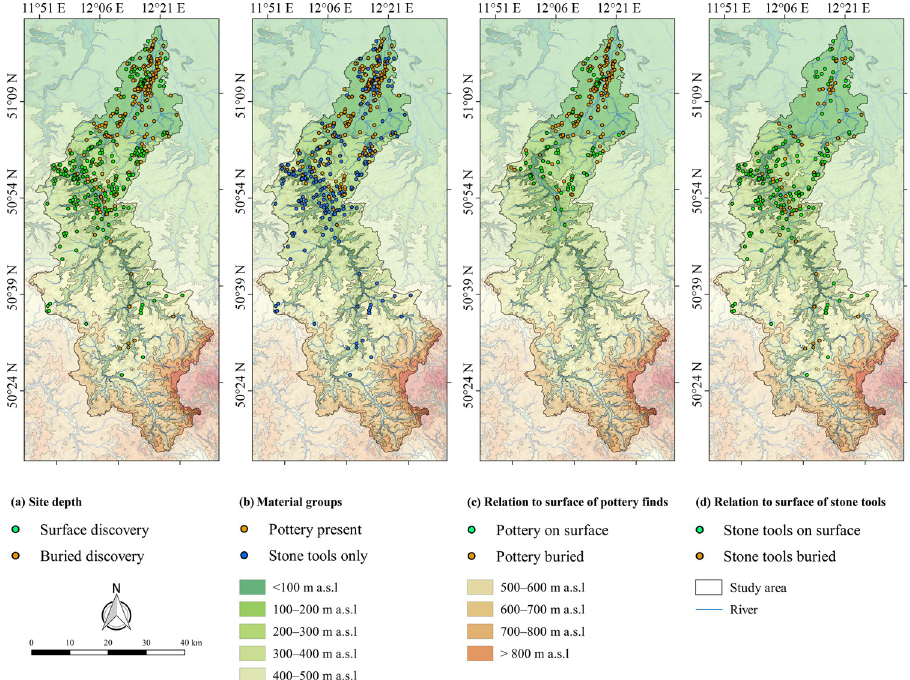
Fig 6. Mapping of datasets used in random forests analyses. (a) Site depth, (b) material groups (c) depth of pottery and (d) stone tools (Table 1). Rivers are plotted according to the European Catchments and Rivers network system [60]. The topography is based on the SRTM 90 m Digital Elevation Database version 4.1 [61–63].Topography and rivers have been modified according to older topographic maps (S2 Table). See Fig 2 for a location of the urban areas mentioned in the text.